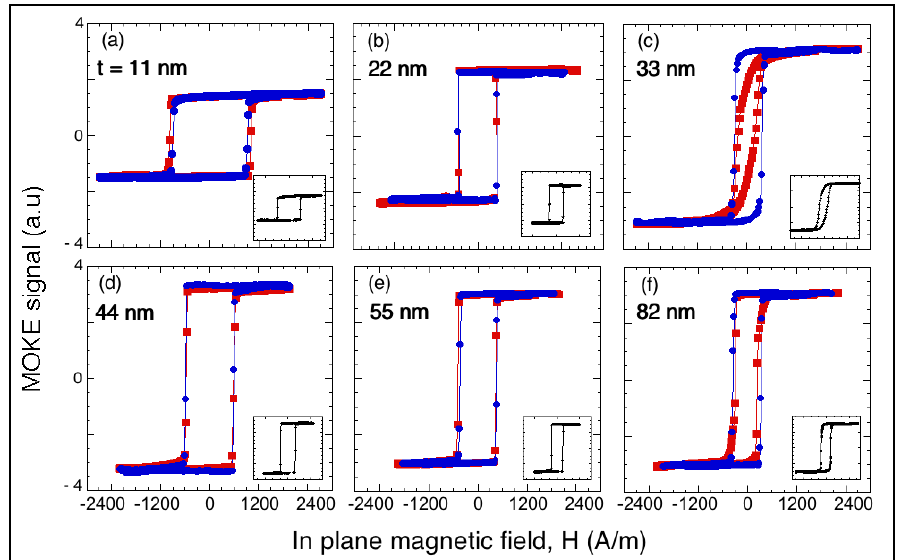
Figure 2. ( a – f ) Magneto-optical Kerr e ff ect (MOKE) hysteresis loops corresponding to as-deposited Fe films with di ff erent thickness t . Films were successively magnetized along two mutually perpendicular in-plane directions defined as L (square red symbols) and T (circular blue symbols). Insets show loops obtained when films were magnetized at 45 ◦ from the L and T directions. For all samples, the three loops were very similar, reinforcing their in-plane isotropic magnetic properties. Horizontal and vertical scales are the same for all of graphics, including insets; lines are visual guides.